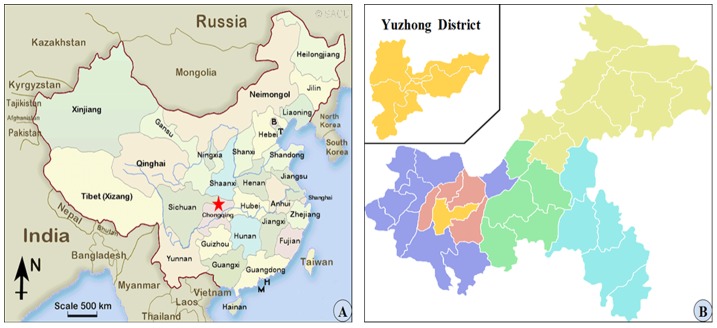
Map of study location.A, Chongqing is located in western China (red pentagram). B, The urban area of Chongqing municipality includes nine districts. Yuzhong District is the central (yellow) and most densely populated district. There are 12 blocks and about 660,000 permanent population in Yuzhong district.